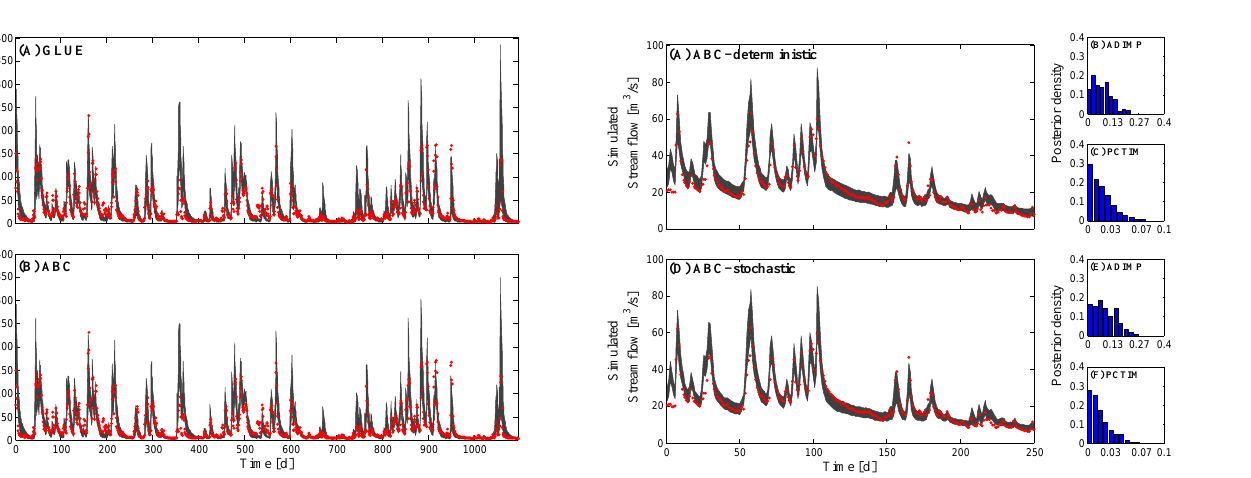
Fig. 15. Illustration of the effect of measurement data uncertainty on the ABC-derived posterior parameter and streamflow uncer- tainty for a representative 250-day portion of the French Broad cal- ibration data set: (A) 95% simulation uncertainty assuming a de- terministic, Y ← H ( θ |· ) , and (D) stochastic model operator, Y ← H ( θ |· ) + N( 0 , ˆ σ ˜ ) with discharge measurement error derived from Y the nonparametric estimator in Eq. (11). The observed discharge data are indicated with solid red dots. The histograms at the right- hand side of each individual panel plot the corresponding marginal posterior distributions of the SAC-SMA model parameters ADIMP and